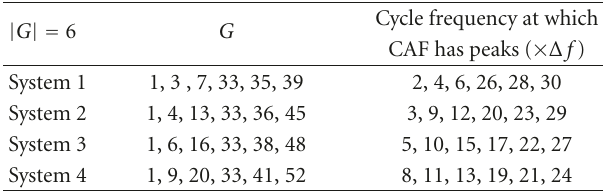
Figure 8: Channel model. Table 1: Simulation parameters.